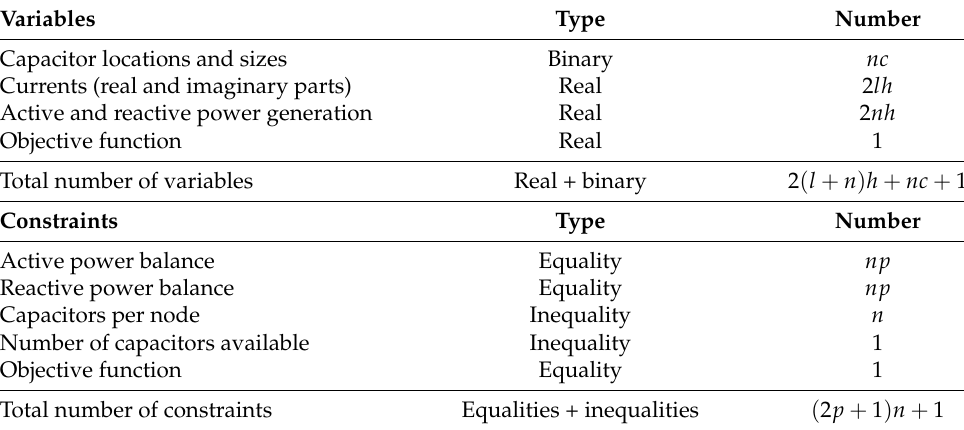
Table 1. Characterization of the MIQC model